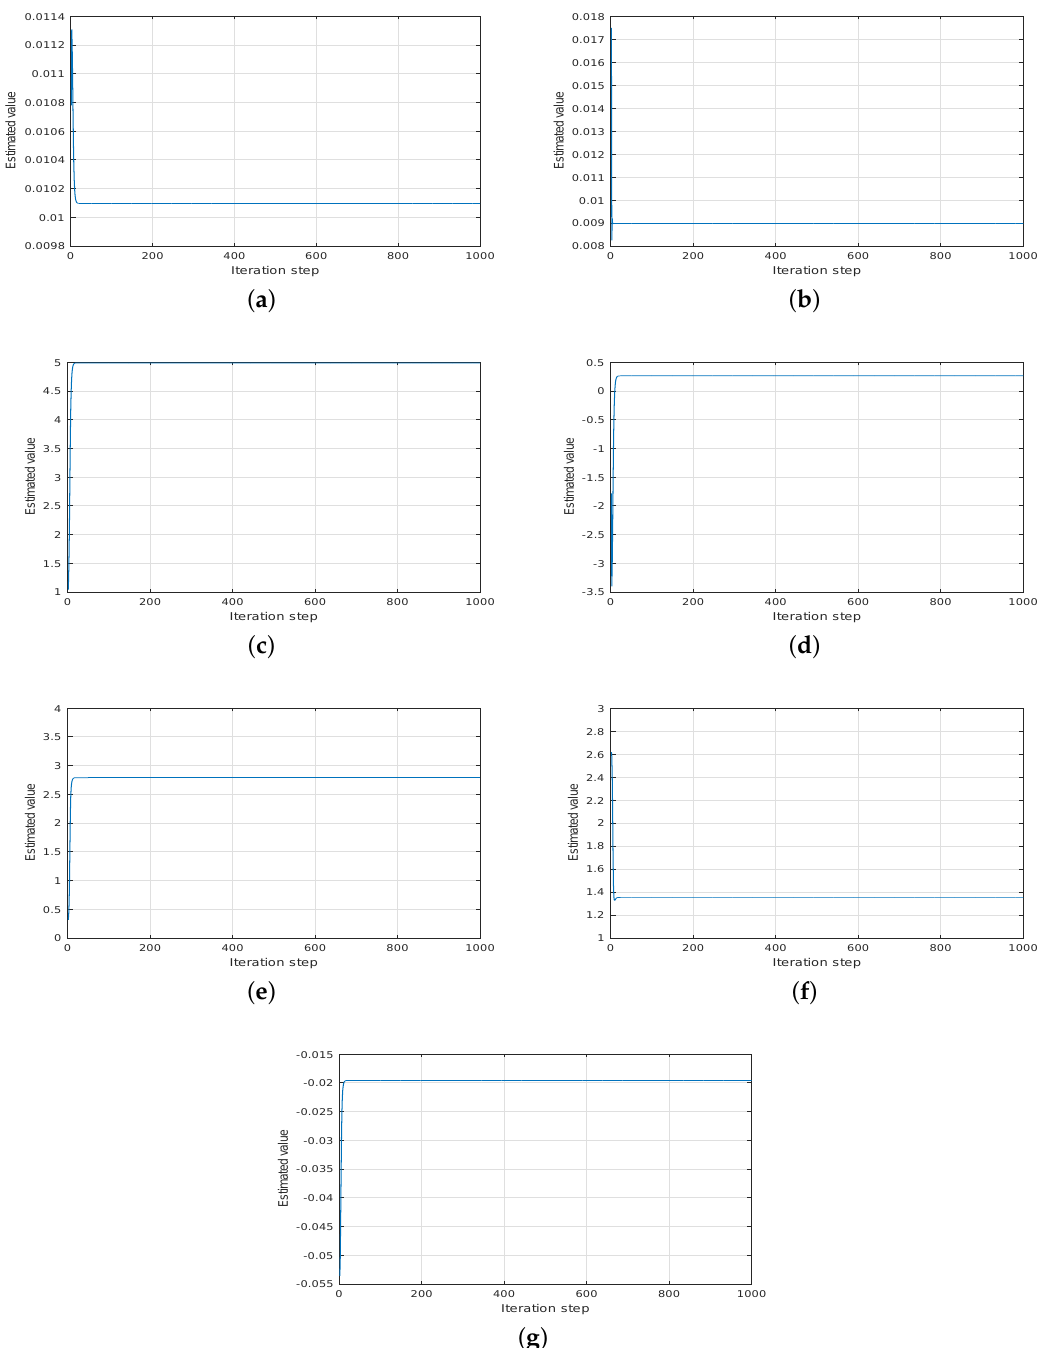
Figure 4. The iterations of estimated parameters based on ECM algorithm. ( a ) The iteration of ˆ µ ; ( b ) The iteration of ˆ σ B ; ( c ) The iteration of ˆ µ 1 ; ( d ) The iteration of ˆ µ 3 ; ( e ) The iteration of ˆ σ 1 ; ( f ) The iteration of ˆ σ 3 ; ( g ) The iteration of ˆ λ 2